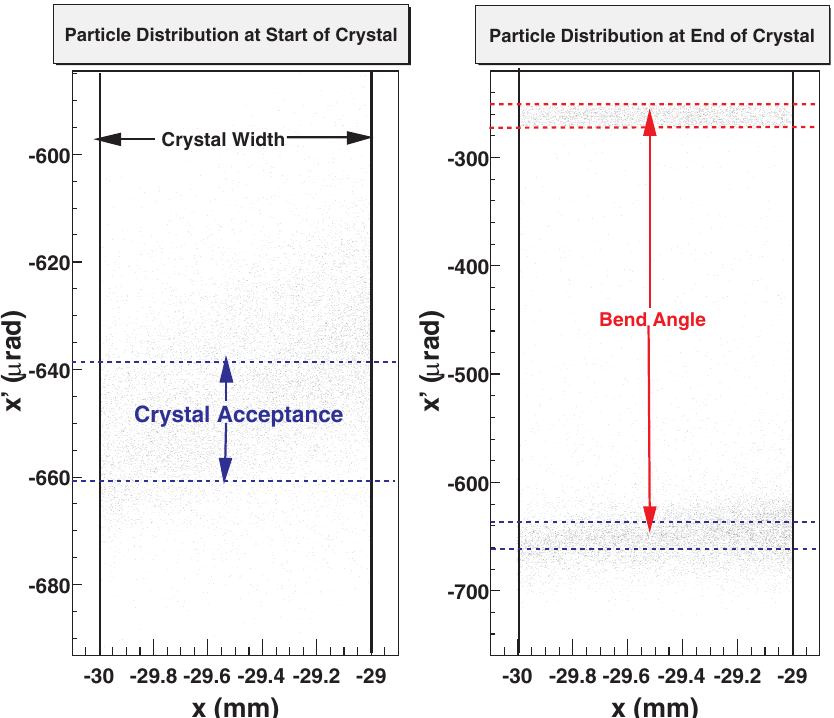
FIG. 3. (Color) Simulation of crystal channeling of particles hitting a silicon crystal. The left figure shows the horizontal phase space at the entrance to the crystal, indicating the crystal angular acceptance. The right figure shows the same phase space at the end of the crystal. The horizontal blue and horizontal red dashed lines indicate the angular acceptance and emittance of the crystal.